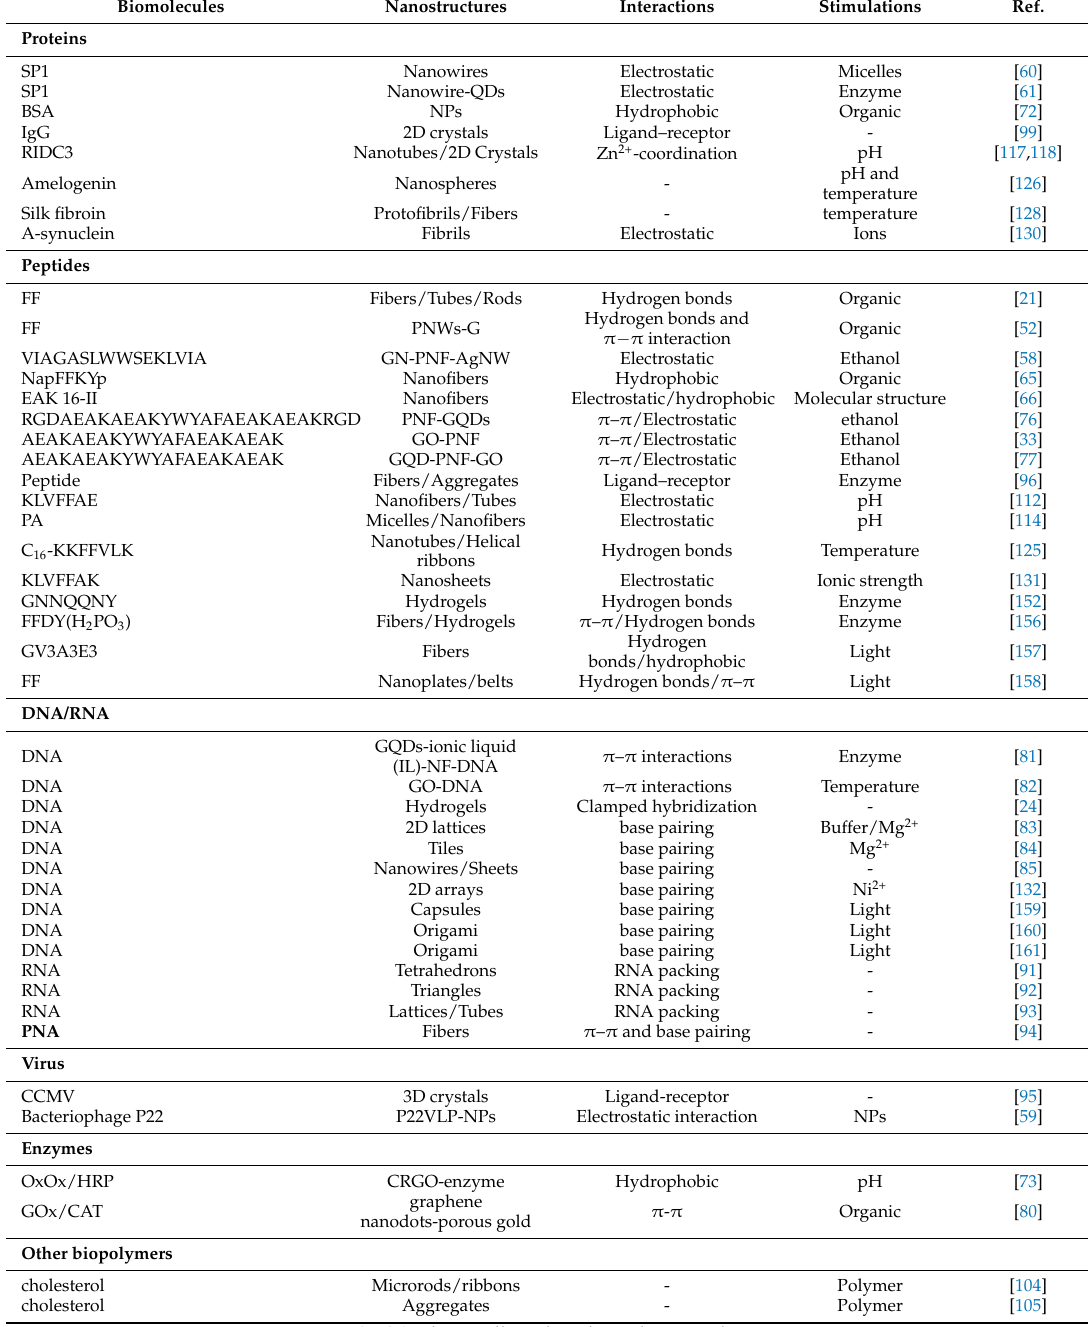
Table 1. A summary of the formed nanostructures via biomolecular self-assembly, and the internal interactions as well as external